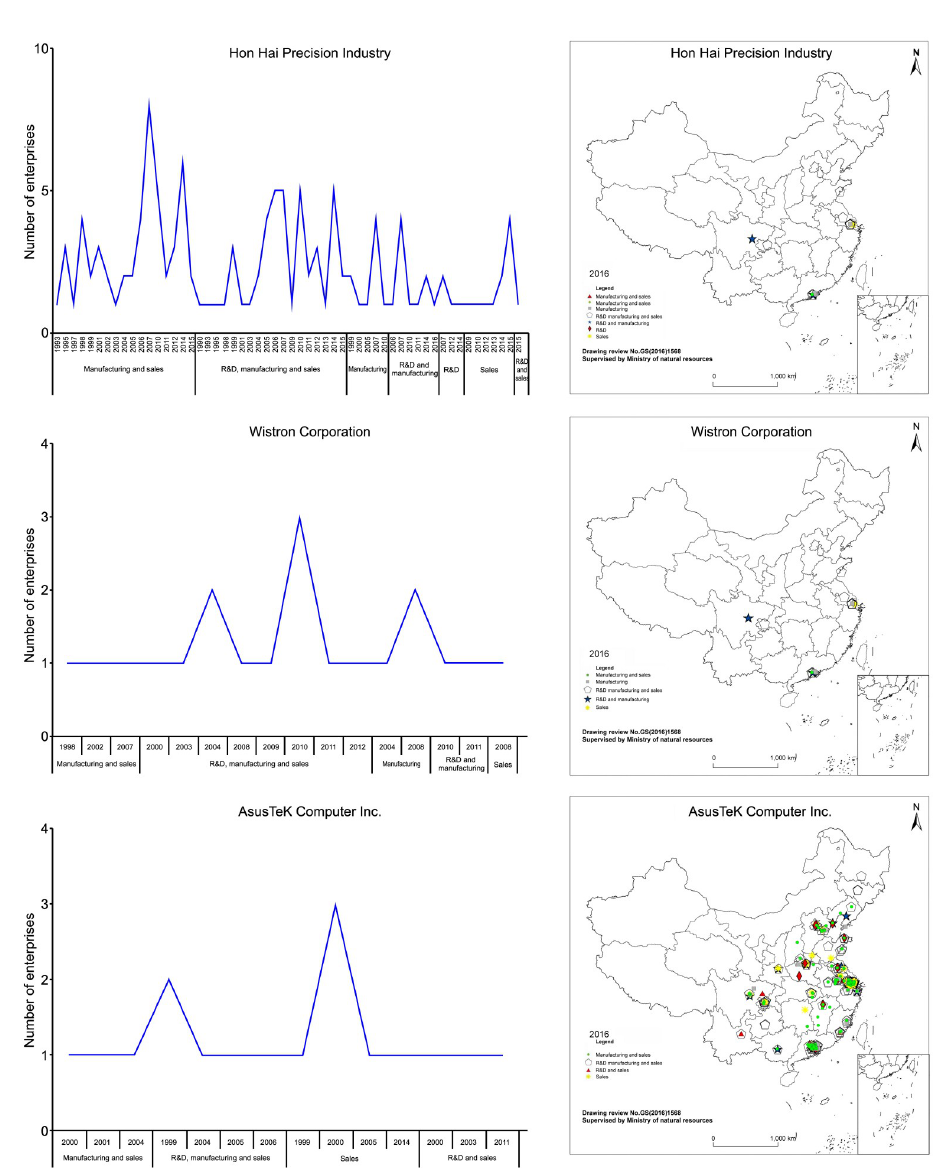
Fig 9. Spatiotemporal distribution of the value chain organization model of Hon Hai Precision Industry, Wistron Corporation, and AsusTeK.